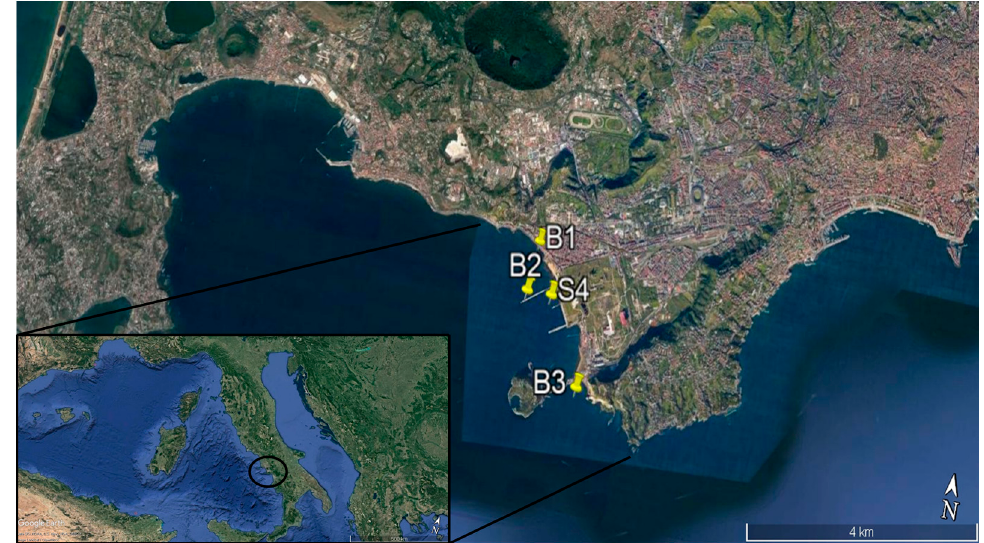
Figure 1. The sampling sites in the Gulf of Naples (Mediterranean Sea). B1, B2, B3 correspond to the stations used for sampling sediments for isolation of bacteria. S4 corresponds to the station where sediments were sampled for microcosm experiments.